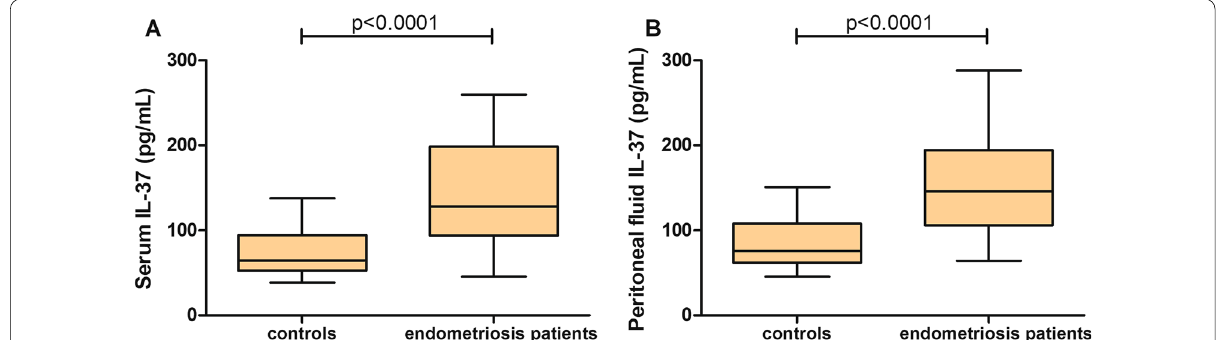
Fig. 1 Elevated serum ( A ) and peritoneal fluid ( B ) levels of IL-37 in endometriosis patients compared to control females